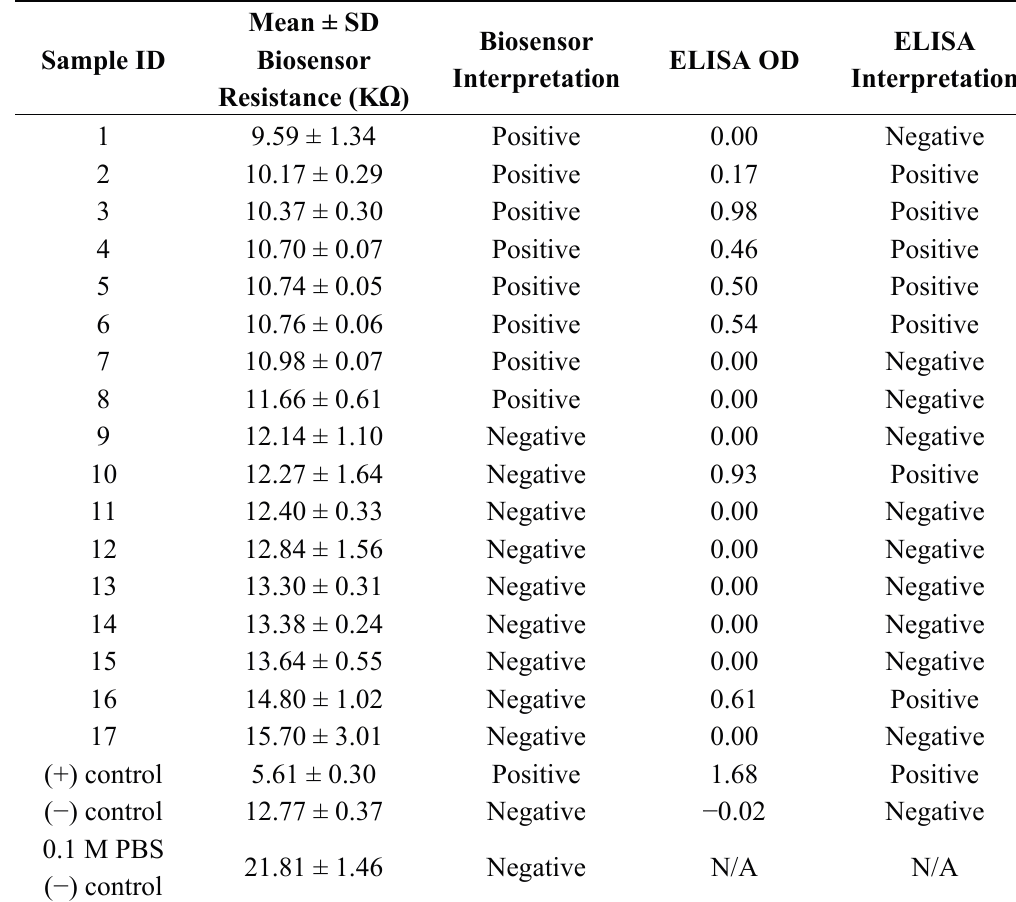
Table 2. Comparison between a conductometric biosensor and ELISA in the evaluation of Johne’s